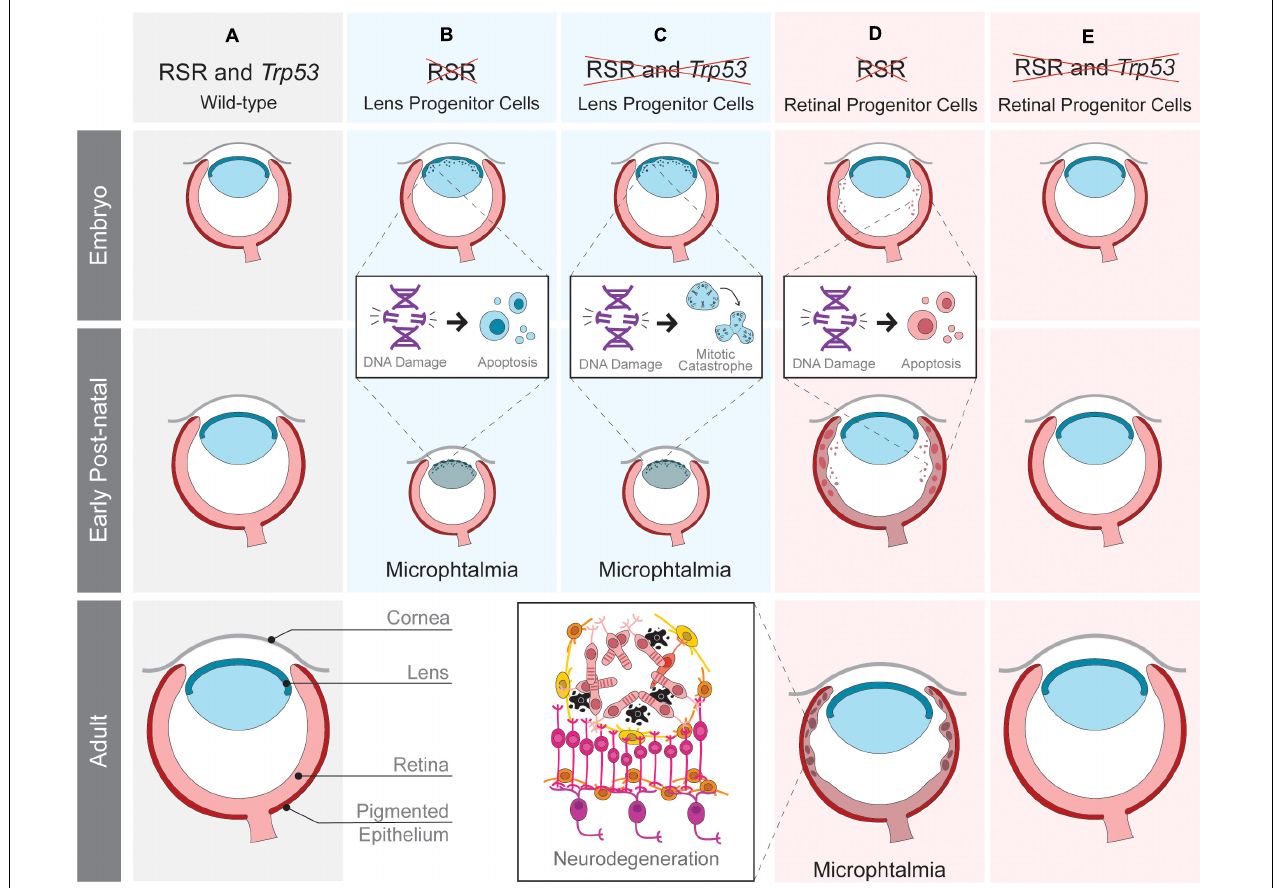
FIGURE 2 | Tissue-specific effects of replication stress response (RSR) inactivation in developing mouse eye. Schematic representation of ocular development in wild-type mice (A) and the consequences of RSR inactivation in lens (B,C) or retinal progenitor cells (D,E) in Trp53- proficient (B,D) and Trp53- deficient